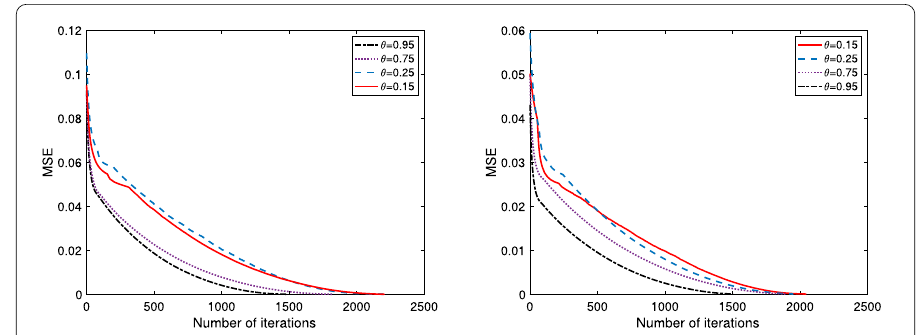
Figure 4 Graph of MSE value and number of iterations when N = 1024, M = 512 and N = 2048, M = 1024